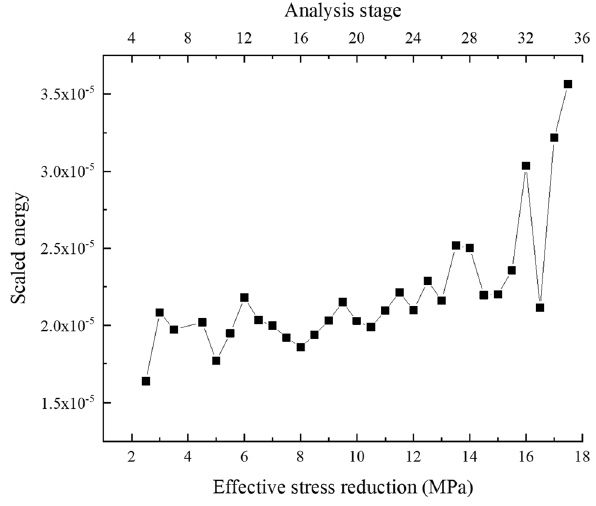
Fig. 18 Scaled energy computed for seismic events in each analysis